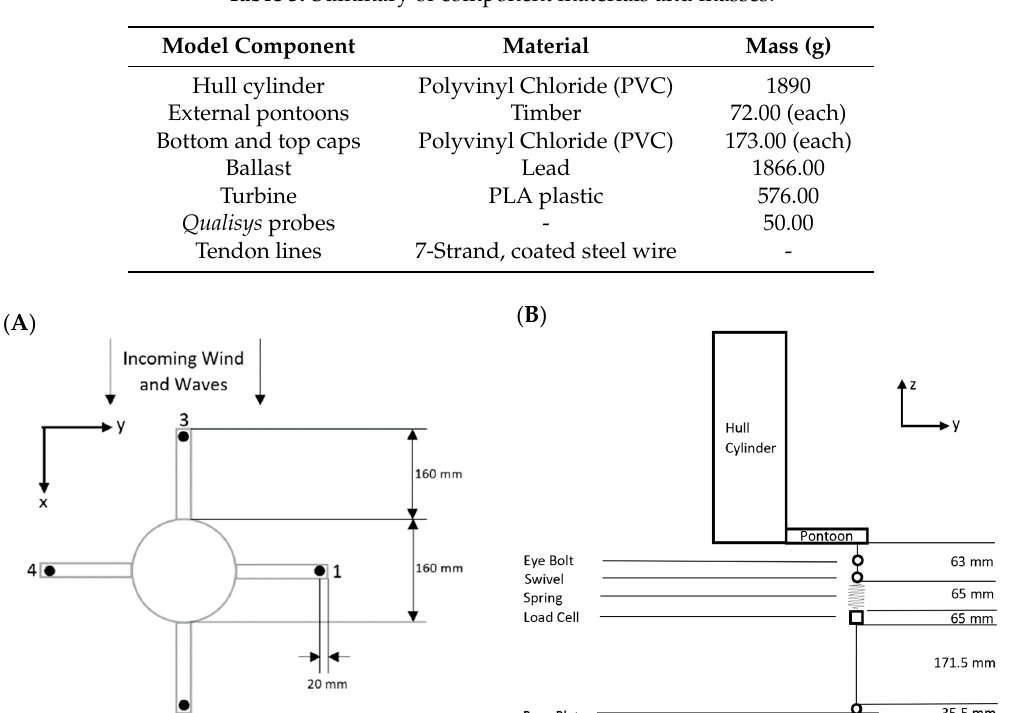
Figure 2. Plan view of external pontoon configuration ( A ) and profile view of tendon arrangement ( B ).